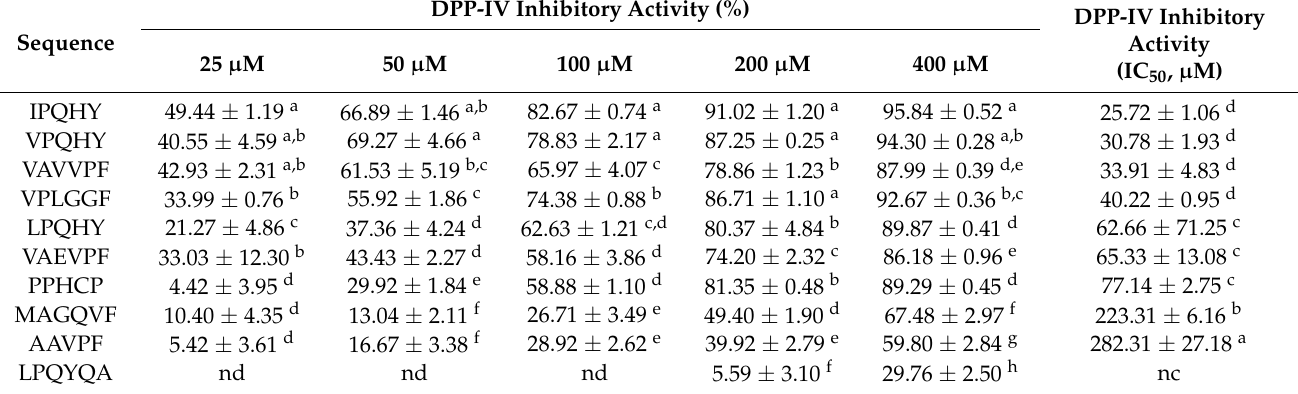
Table 3. DPP-IV inhibitory activities of the oat-derived peptides. The data marked by different letters for each determination were significantly different ( p <